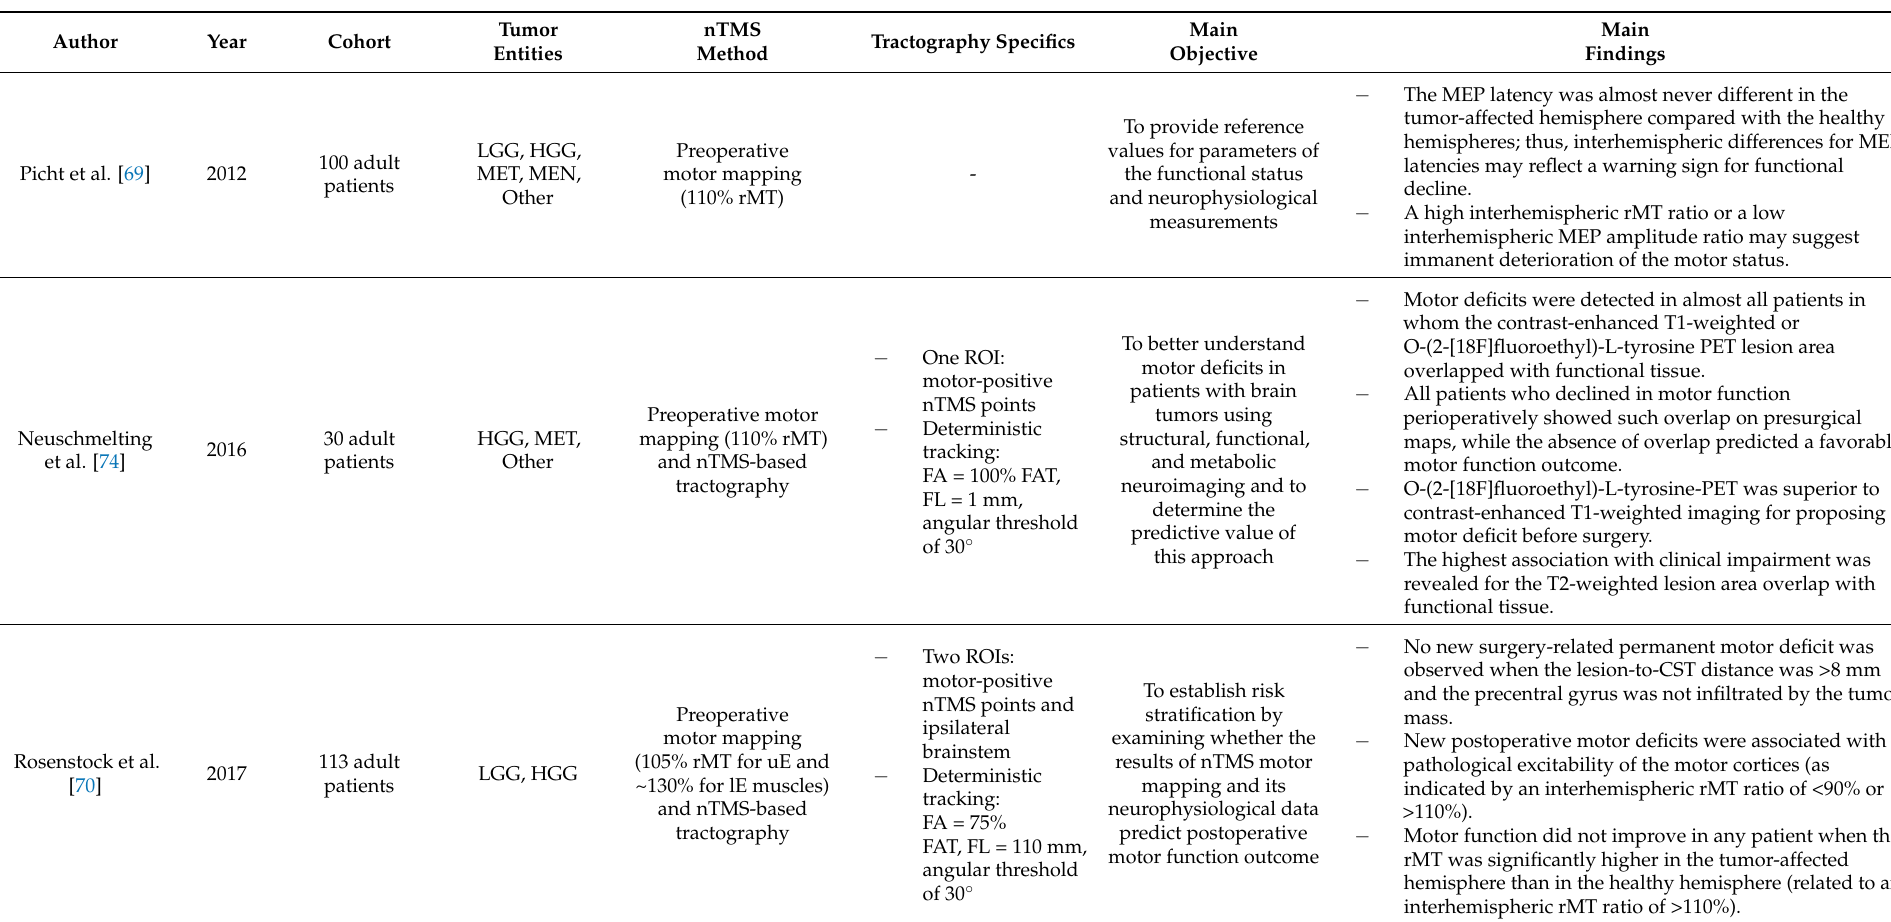
Table 4. Risk stratification and prediction. This table provides an overview of the studies published on risk stratification and prediction using motor mapping by nTMS (using an electric-field-navigated system) with or without additional nTMS-based tractography in patients harboring brain